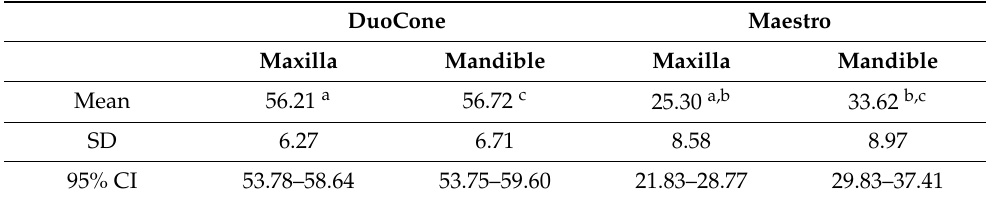
Table 2. Insertion torque values by groups.